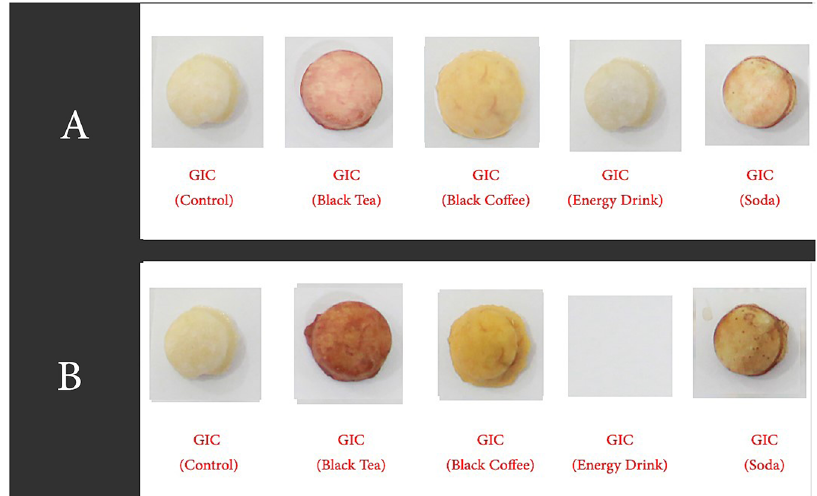
Fig. 4 GIC Speciments ready for measurements. A GIC (after 2 weeks). B GIC (after 4 weeks).